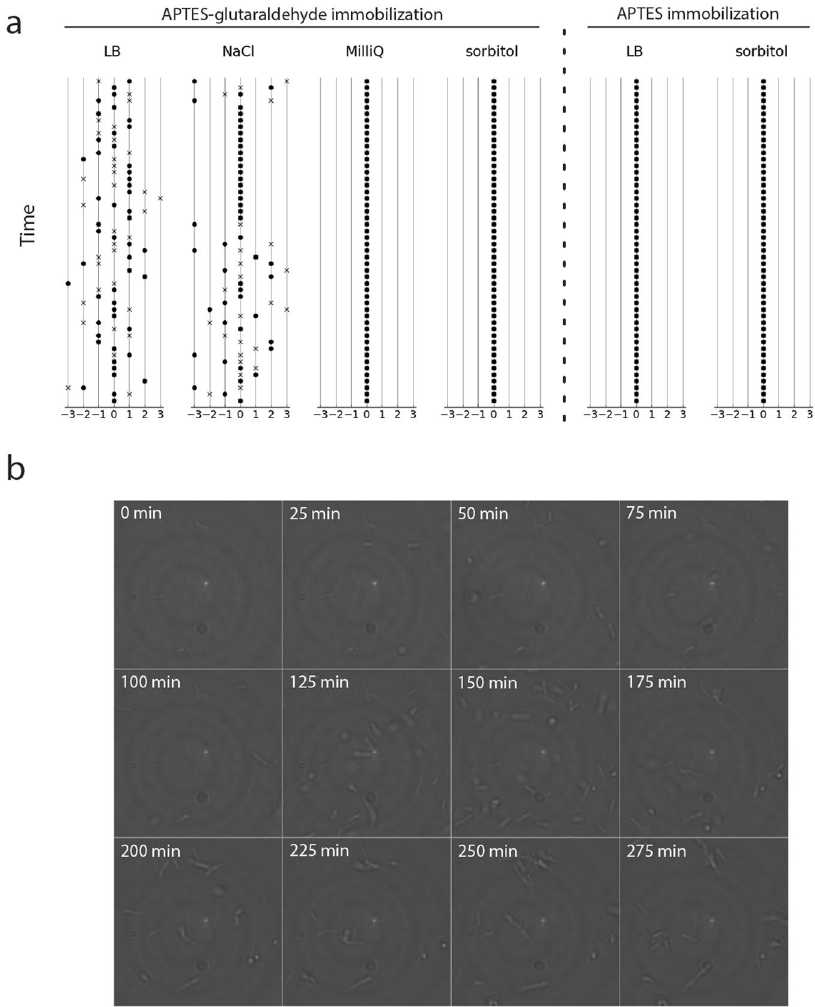
Figure 5. Immobilization of E. coli on APTES-glutaraldehyde- or APTES-treated slides. Panel a shows movement of the cells that were attached to the APTES-glutaraldehyde slides in the indicated solutions; the data are benchmarked against immobilization on APTES. The final concentrations in the attachment solutions are Lysogeny Broth (LB), 75 mM NaCl, milliQ or 150 mM sorbitol, as indicated at the top of the figure. The x-axis of the graphs shows the detected movement between two consecutive frames measured in pixels (Dots represent movement along x-axis, crosses along y-axis). Multiple frames are plotted on the y-axis. Panel b shows growth of E. coli in LB after immobilization of the cells in 150 mM